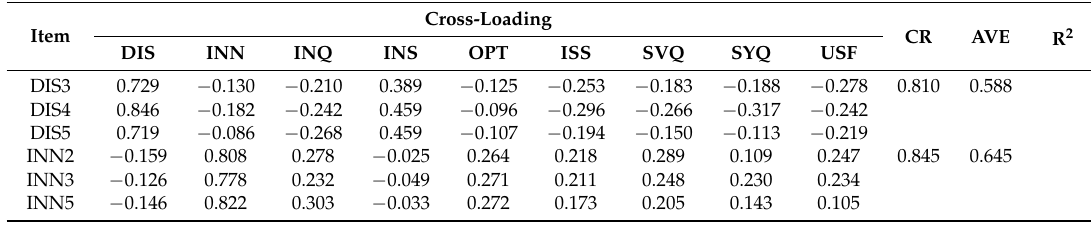
Figure 4. Results of SmartPLS calculation, with respect to measurement model assessments. Table 5. Cross-loading of indicator